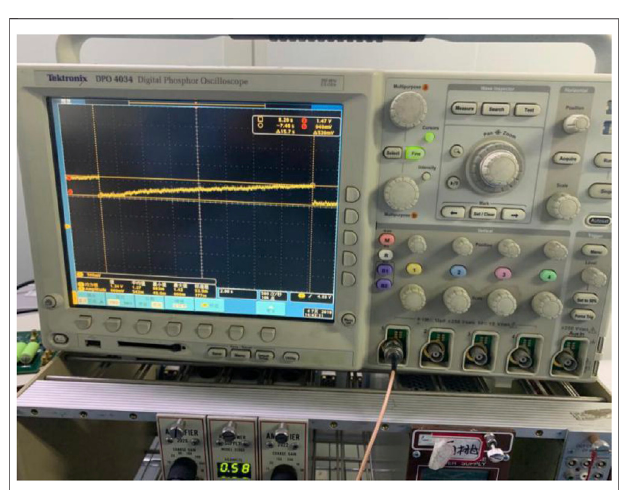
FIGURE 9 | Noise capacitance slope of a preampli fi er circuit.